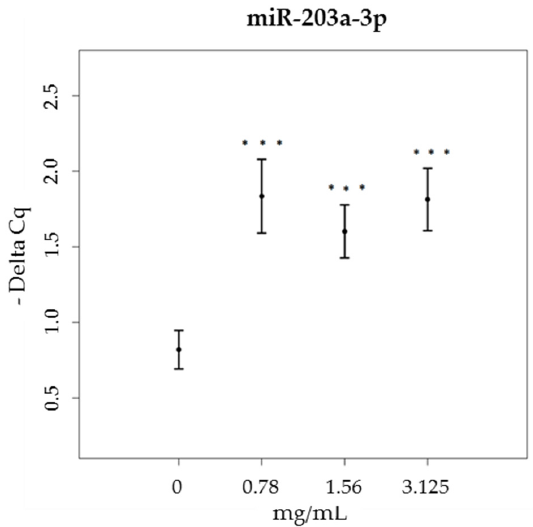
Figure 4. miR-203a-3p expression levels (-Delta Cq) in HaCat cells, treated with increasing concentrations of brown propolis extract (0.78–3.125 mg/mL).